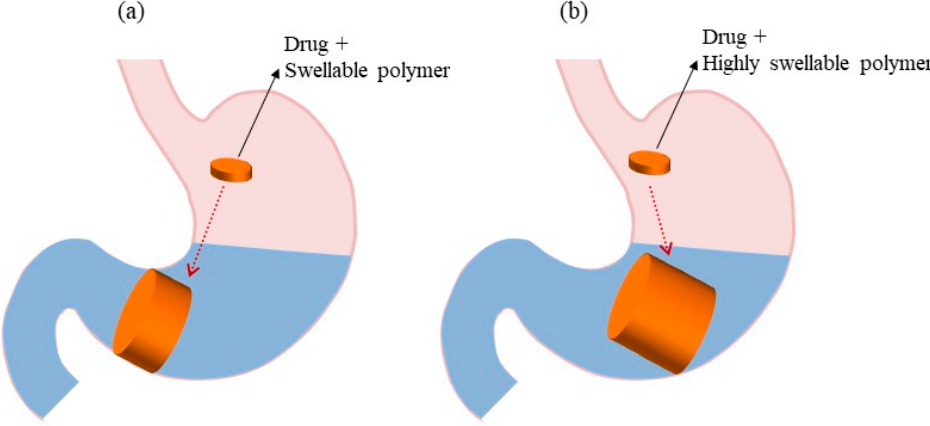
Figure 3. GRDDS based on ( a ) expandable systems and ( b ) superporous hydrogel systems.